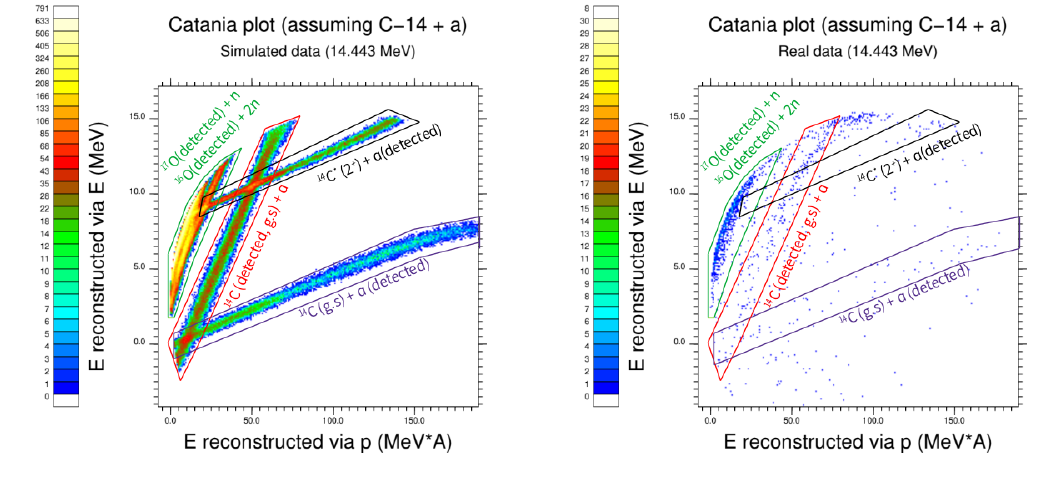
Figure 4: A comparison of the Catania plots generated for 18 O excited to 14.443 MeV, assuming an α -decay and detected 14 C, for Monte Carlo data (left) and real data (right). The individual decay channels are labelled in order to see the overlap of the